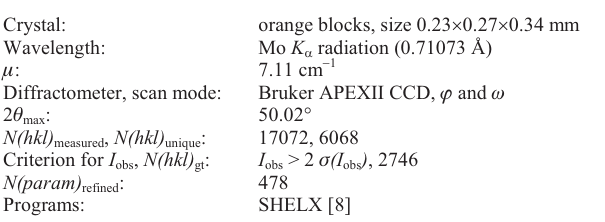
Table 1. Data collection and handling.